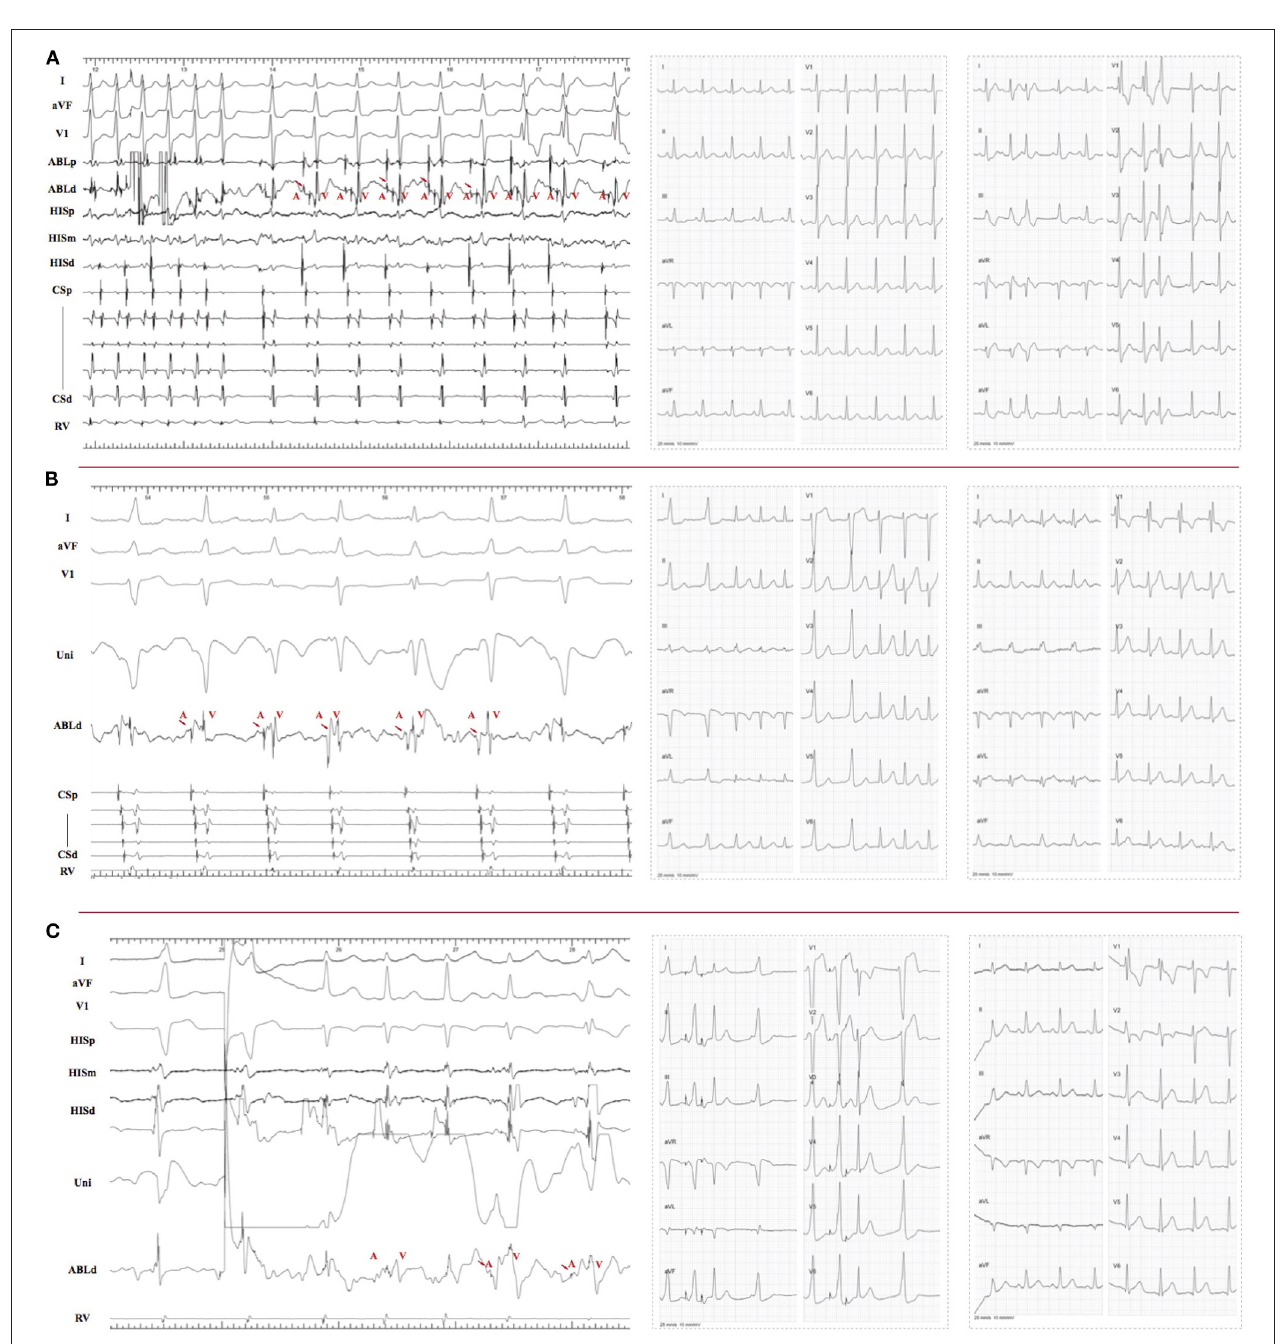
FIGURE 2 | (A) , left panel, RF performed at site 2 and RBBB obtained during ablation. There was “A,” “H,” and “V” recorded at the ablation target; middle panel, ECG before ablation; right panel, right bundle conduction recovered after RF off. (B) , left panel, RF performed at the atrial side of site 3 and caused RBBB during ablation; middle panel, narrow QRS tachycardia without RBBB induced before ablation; right panel, RBBB still existed at the end of the procedure. (C) , left panel, RF performed at site 1 with small “A” potential and lead to RBBB; middle panel, narrow QRS observed during A-pacing before ablation (third beat); right panel, RB conduction recovered when RF terminated. RBB, right bundle